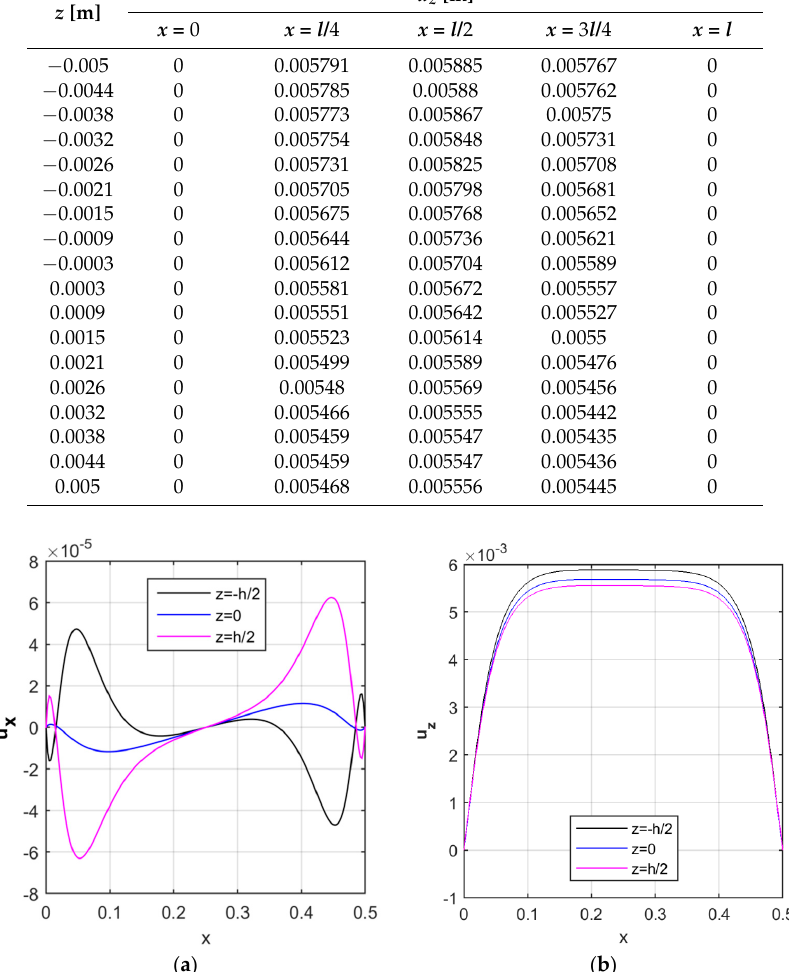
Figure 6. Longitudinal distribution of the axial ( a ) and radial ( b ) displacement components [m], in the middle and external surfaces. Nanomaterials 2019 , 9 , x FOR PEER REVIEW